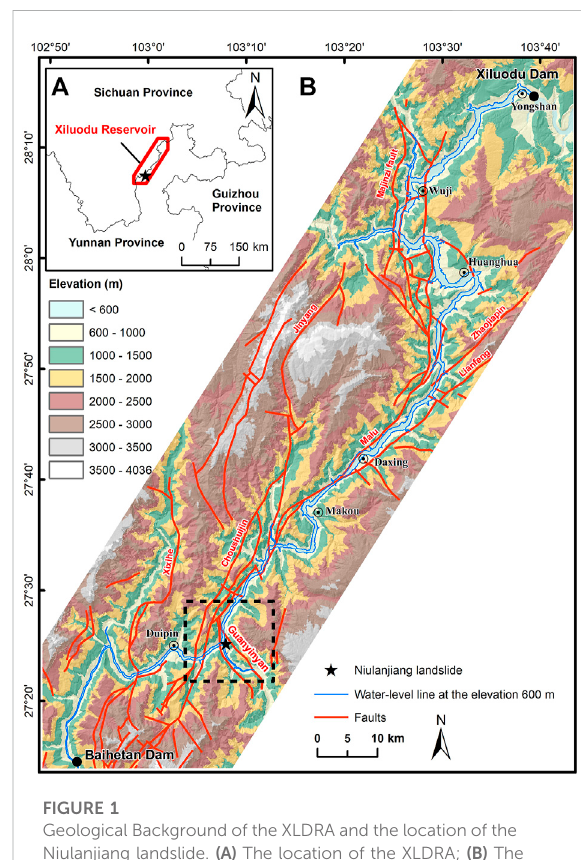
FIGURE 1 Geological Background of the XLDRA and the location of the Niulanjiang landslide. (A) The location of the XLDRA; (B) The location of the Niulanjiang landslide and elevation and faults distribution in